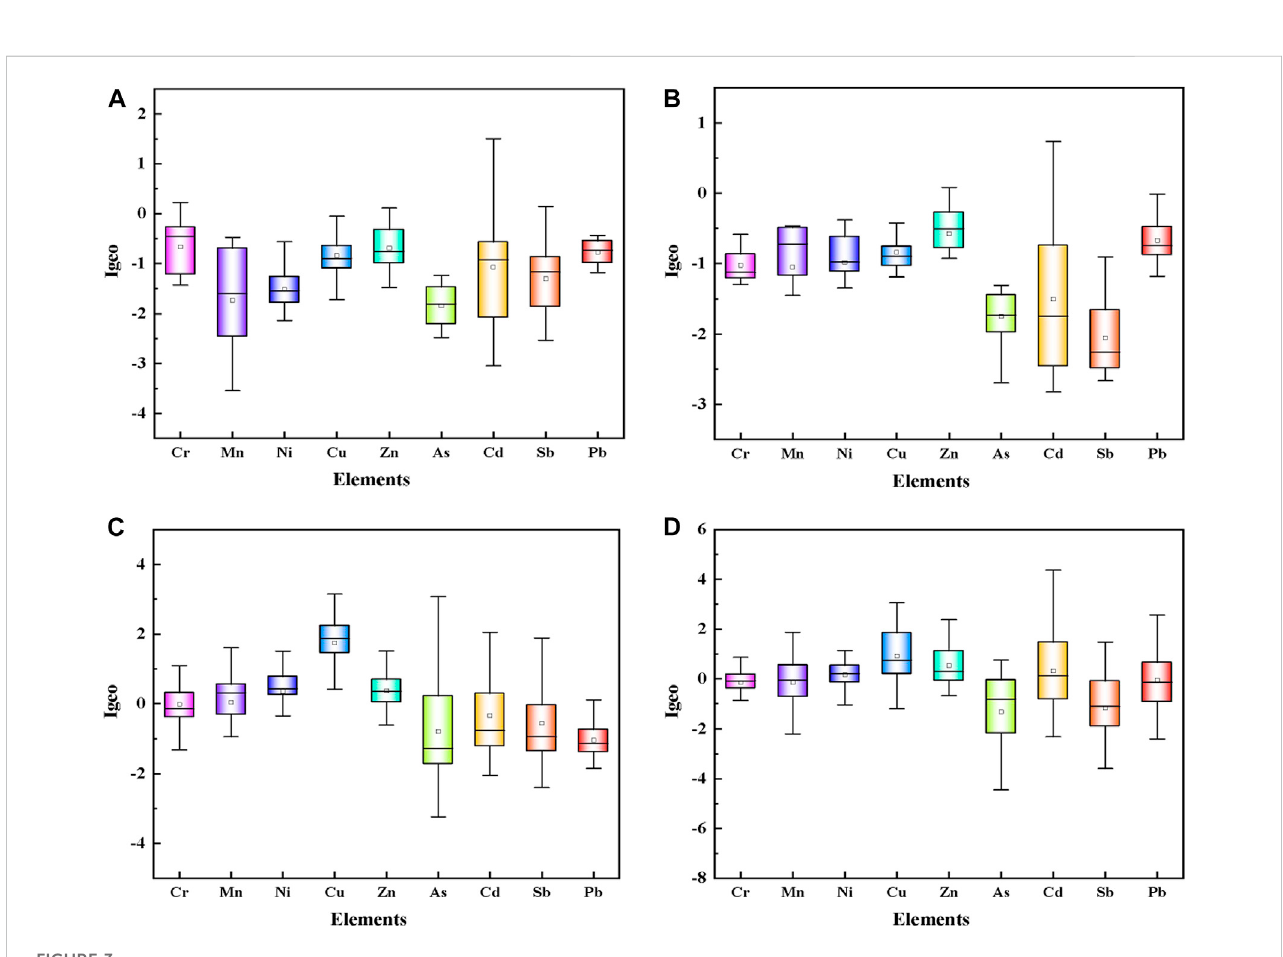
Cu > Ni > As > Cr. The average I geo values of Hg, Cd, and Pb was > 0, and Hg and Cd had different degrees of pollution. Zhang et al. (2015) evaluated the amount of heavy metal contamination in the soil in the potato production area of Panxian and found that the soil was free of contamination from Cu and As, while there was slight contamination